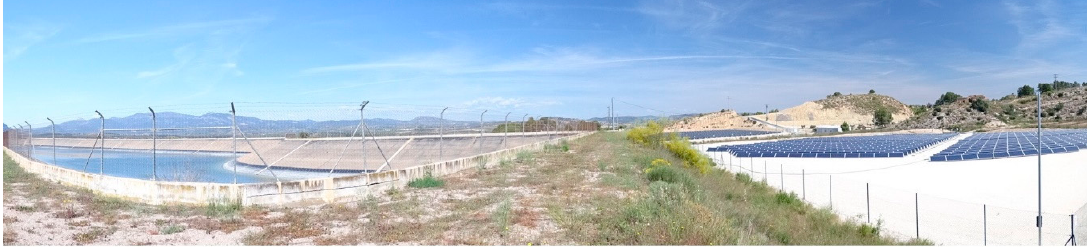
Figure 6. Reservoirs and Solar installations. Source: Own.